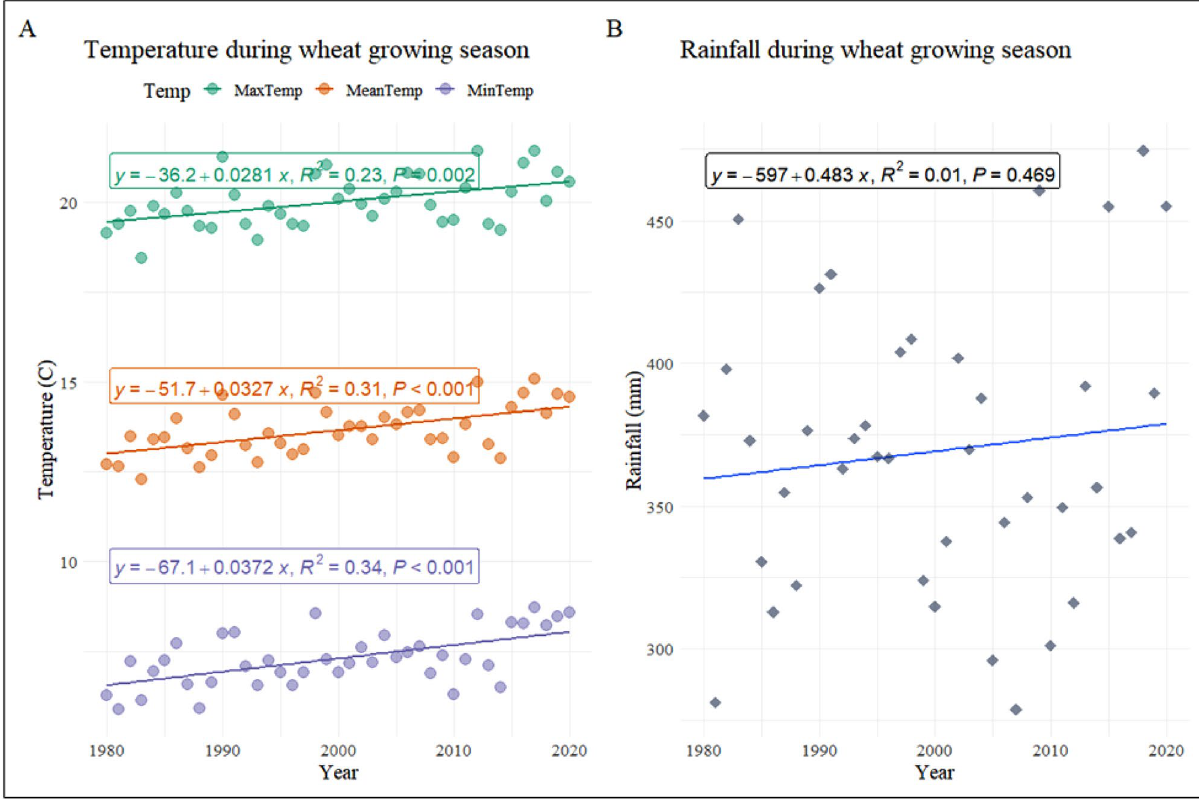
Figure 4. ( A ) T max , T min , and T avg , showed significant slopes throughout WGS in the SE-US between 1980 and 2020. ( B ) The rainfall also showed a non-significant trend in the SE-US over WGS between 1980 and